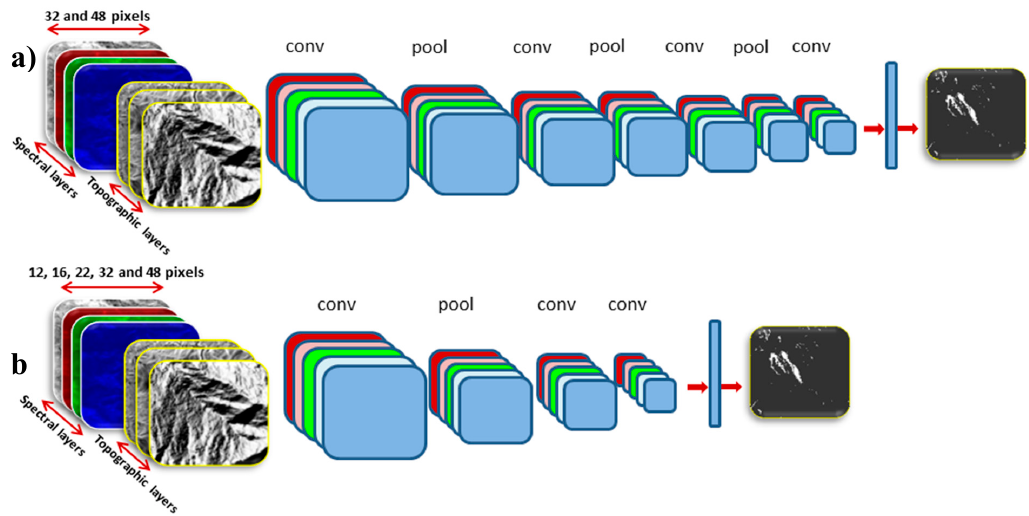
Figure 5. The CNN architectures with ( a ) seven-layer depth (D-CNN) and ( b ) four-layer depth CNN, training separately with five spectral layers and eight layers that included spectral plus with topographical ones. Input window sizes of 32 × 32 and 48 × 48 were used for D-CNN, and window sizes of 12 × 12, 16 × 16, 22 × 22, 32 × 32 and 48 × 48 were used for CNN. The four-layer depth CNN was fed separately with all input window sizes of training sample patches ones using the four original spectral bands (R,G,B, NIR) and the NDVI. Since we fed this CNN with five-layer images, the input sample patch had a×a× 5 units (where a is: 12, 16, 22, 32, and 48). In another training process, we also used three topographic layers, namely slope, aspect and plan curvature, in addition to this spectral information, to train the method. In this case, the CNN was fed by the input sample patches with a×a× 8 units, where a×a is the size of one layer of sample patches, and 8 is the number of different layers used for the analysis. We used 40 feature maps, hence the number of a×a× 5 × 12 different weights were trained during the first hidden layer of the four-layer depth CNN by using input window sizes of a×a . As a result, 12 feature maps with ( a − 4)×( a − 4) × 1 units were obtained through a convolution layer with the kernel size of 5. A (cid:4673) × (cid:4672) (cid:3028) (cid:2879) (cid:2872) (cid:4673) × 1 in the same number of feature maps from the previous layer. The resulting to (cid:4672) (cid:3028) (cid:2879) (cid:2872) (cid:2870) (cid:2870)